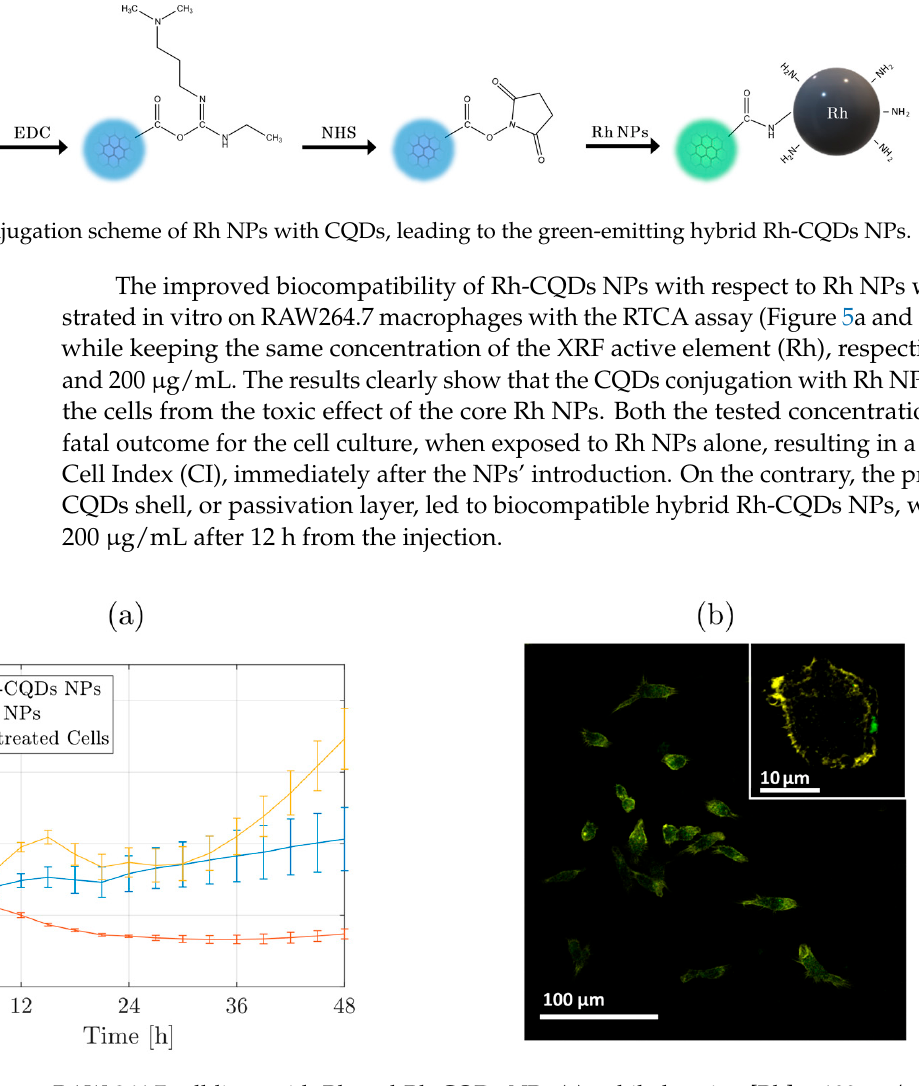
Figure 5. RTCA assay on RAW 264.7 cell lines with Rh and Rh-CQDs NPs ( a ), while keeping [Rh] = 100 µ g/mL. The cell index is normalized ( CI = 1) at the time when NPs were added ( t = 0). Confocal microscopy images ( b ) of fixed and stained RAW264.7 Macrophages incubated for 24 h with Rh-CQDs (100 µ g/mL, in green), at 20 × (63 × in the insert). Alexa 555 Phalloidin (yellow) is used to visualize the plasma membrane.